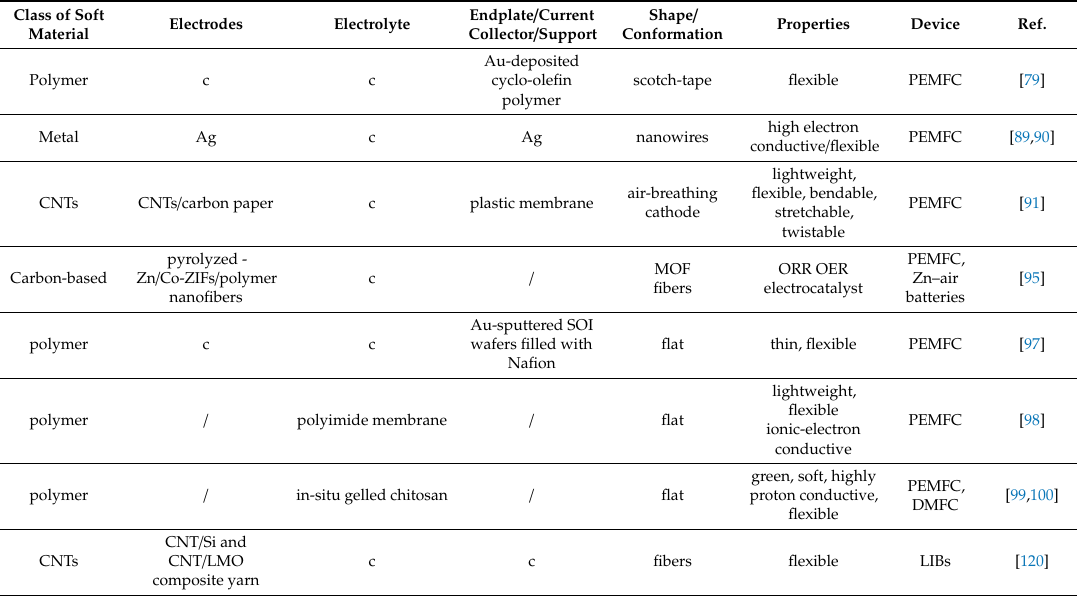
Table 2. Summary of soft materials for wearable energy conversion and storage